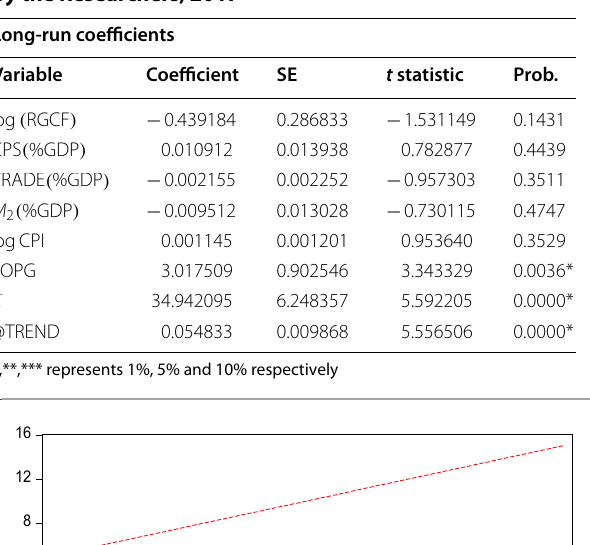
Table 7 Long-run parameter estimates. Source : Computed